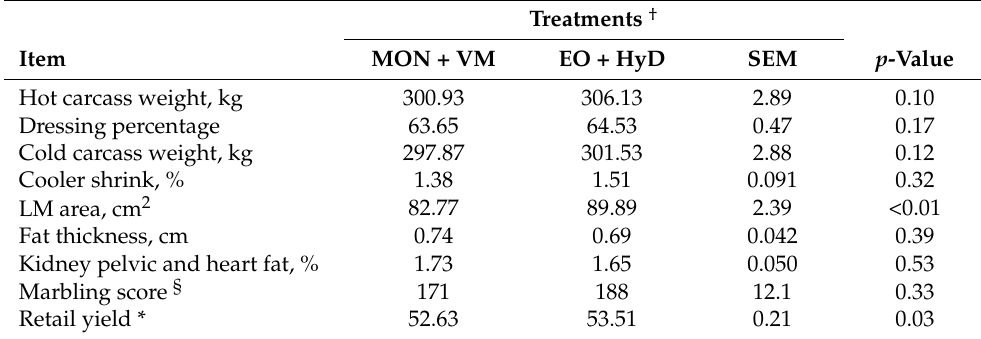
Table 3. Effect of treatments on carcass characteristics of finishing